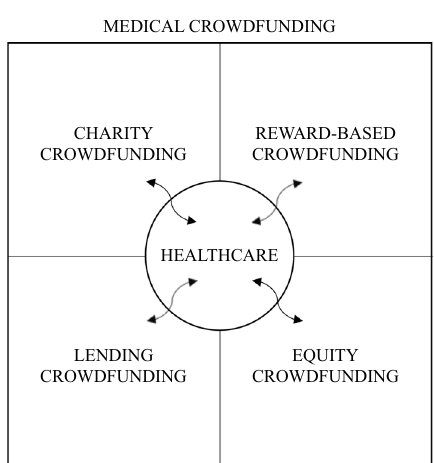
Fig. 1 Medical crowdfunding